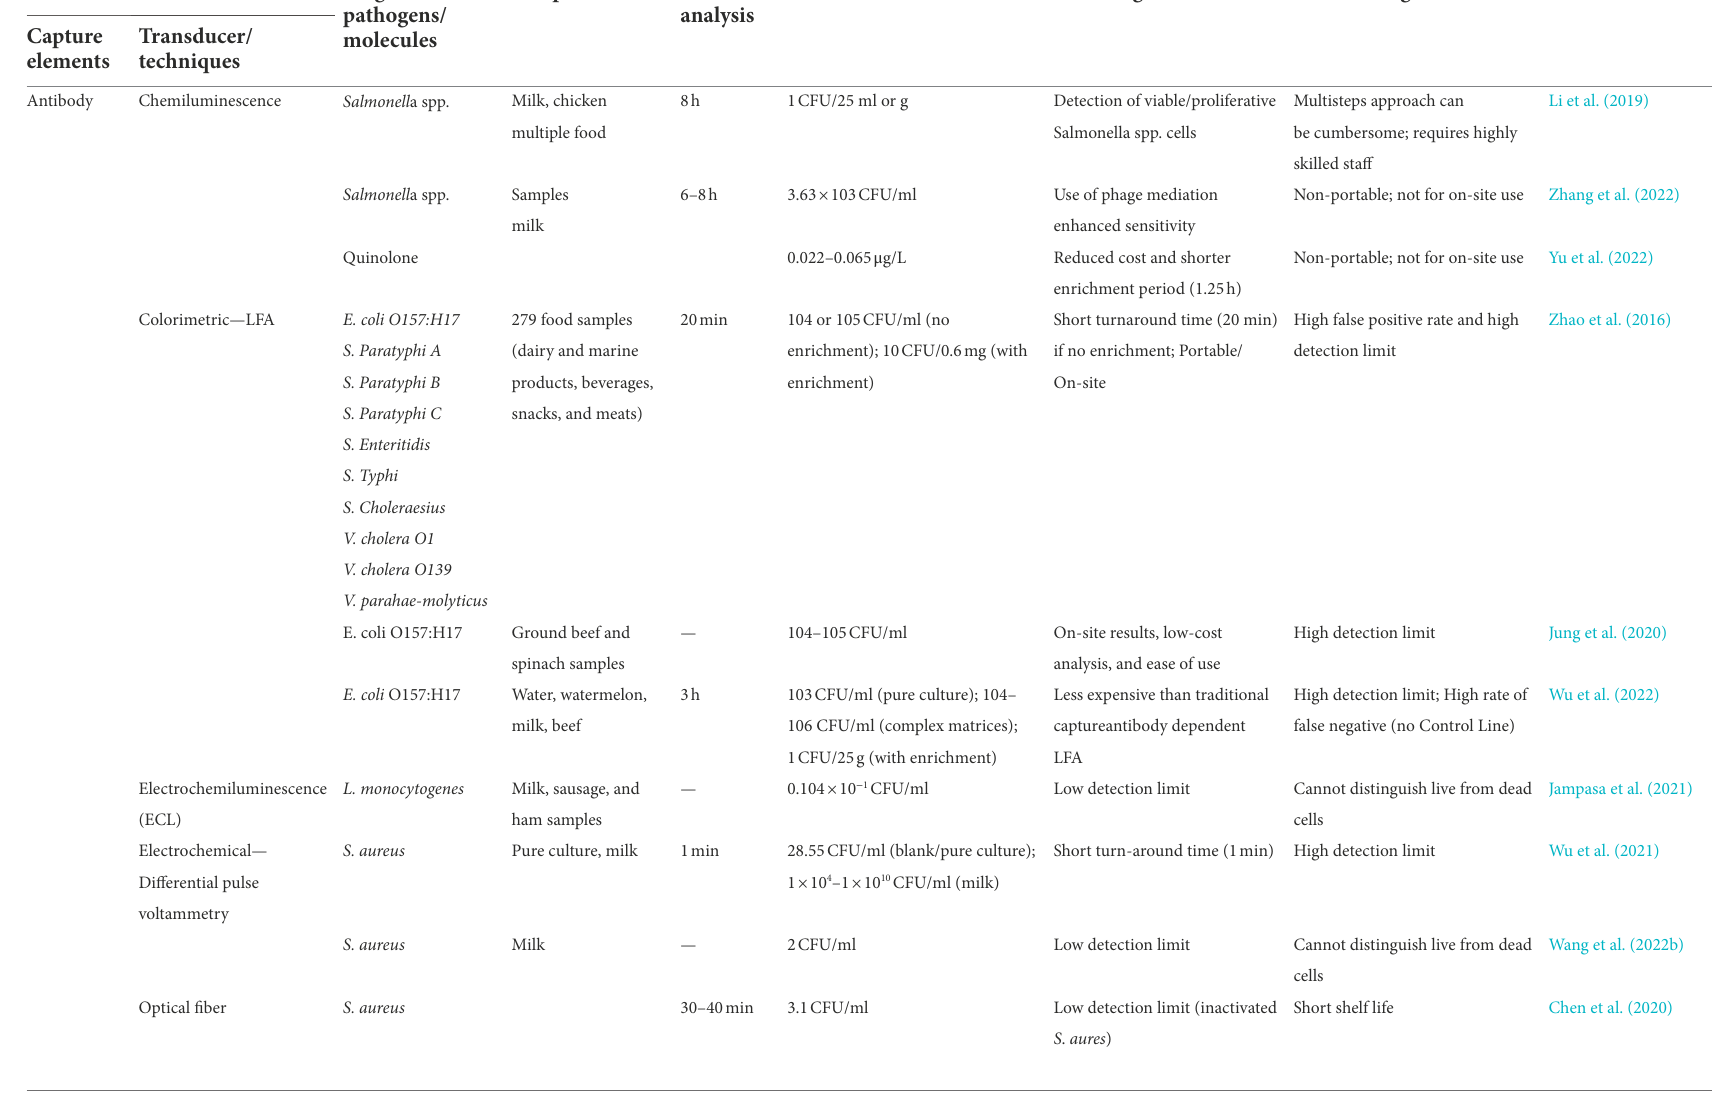
TABLE 1 Recently developed biosensors for foodborne pathogens